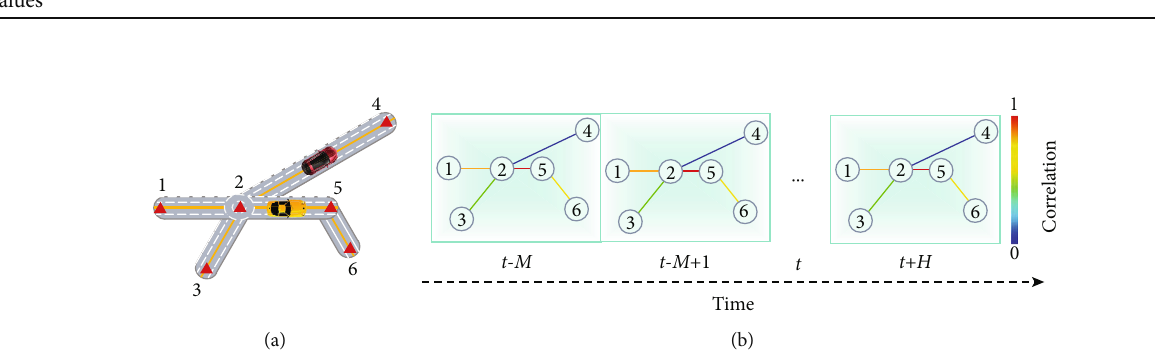
Figure 4: (a) Toll-gates in a road network. (b) Spatiotemporal correlation.